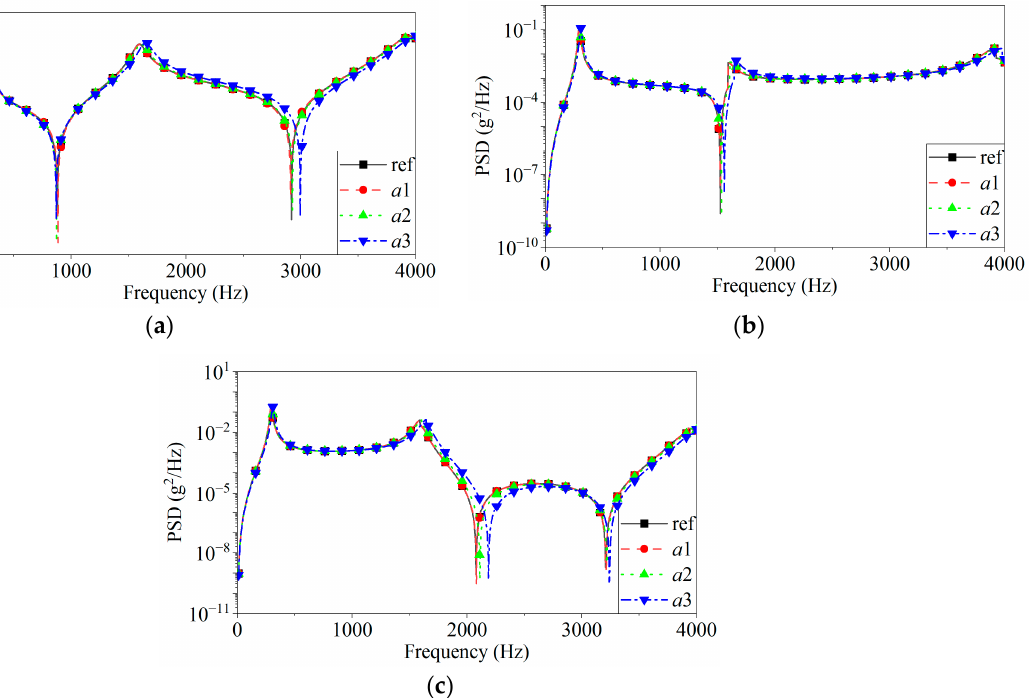
Figure 6. PSD curves of acceleration in the z-direction under different static loads at various locations: ( a ) PSD curves for a point located at x = 150 mm ( b ) PSD curves for a point located at x = 100 mm; ( c ) PSD curves for a point located at x = 75 mm.